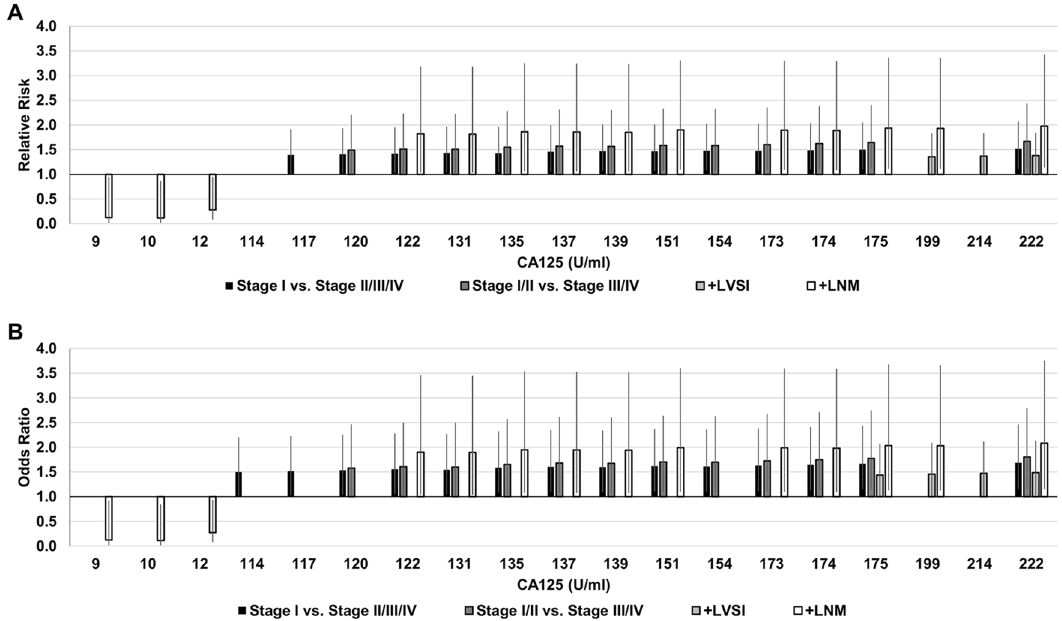
Figure 5. Relative risk (RR) ( A ) and odds ratio (OR) ( B ) of significant ( p ≤ 0.05) CA125 thresholds. P values for OR and RR were calculated with Fisher’s exact test using a two-sided 95% CI, where the CI was calculated using a normal approximation. Bars represent 95%